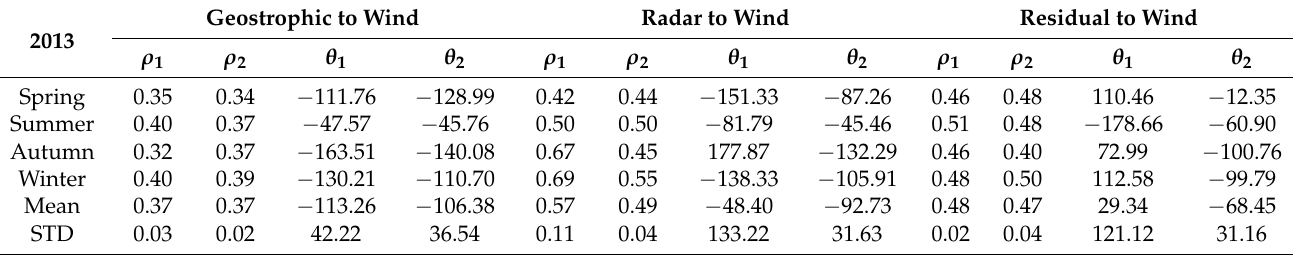
Figure 8. Spatially averaged u and v components of the daily wind, SGV and HFR velocity time series related to box 1 ( a , b ) and box 2 ( c , d ). Table 3. Complex correlation coefficients and veering angles of the HFR, SGV, and residual data with the wind in four seasons.